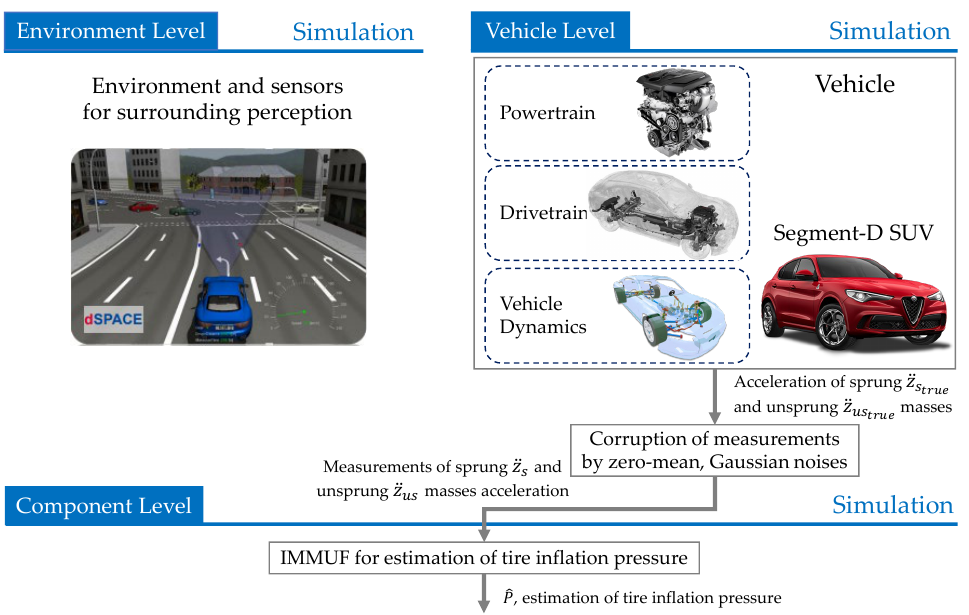
Figure 3. High-fidelity vehicle simulation